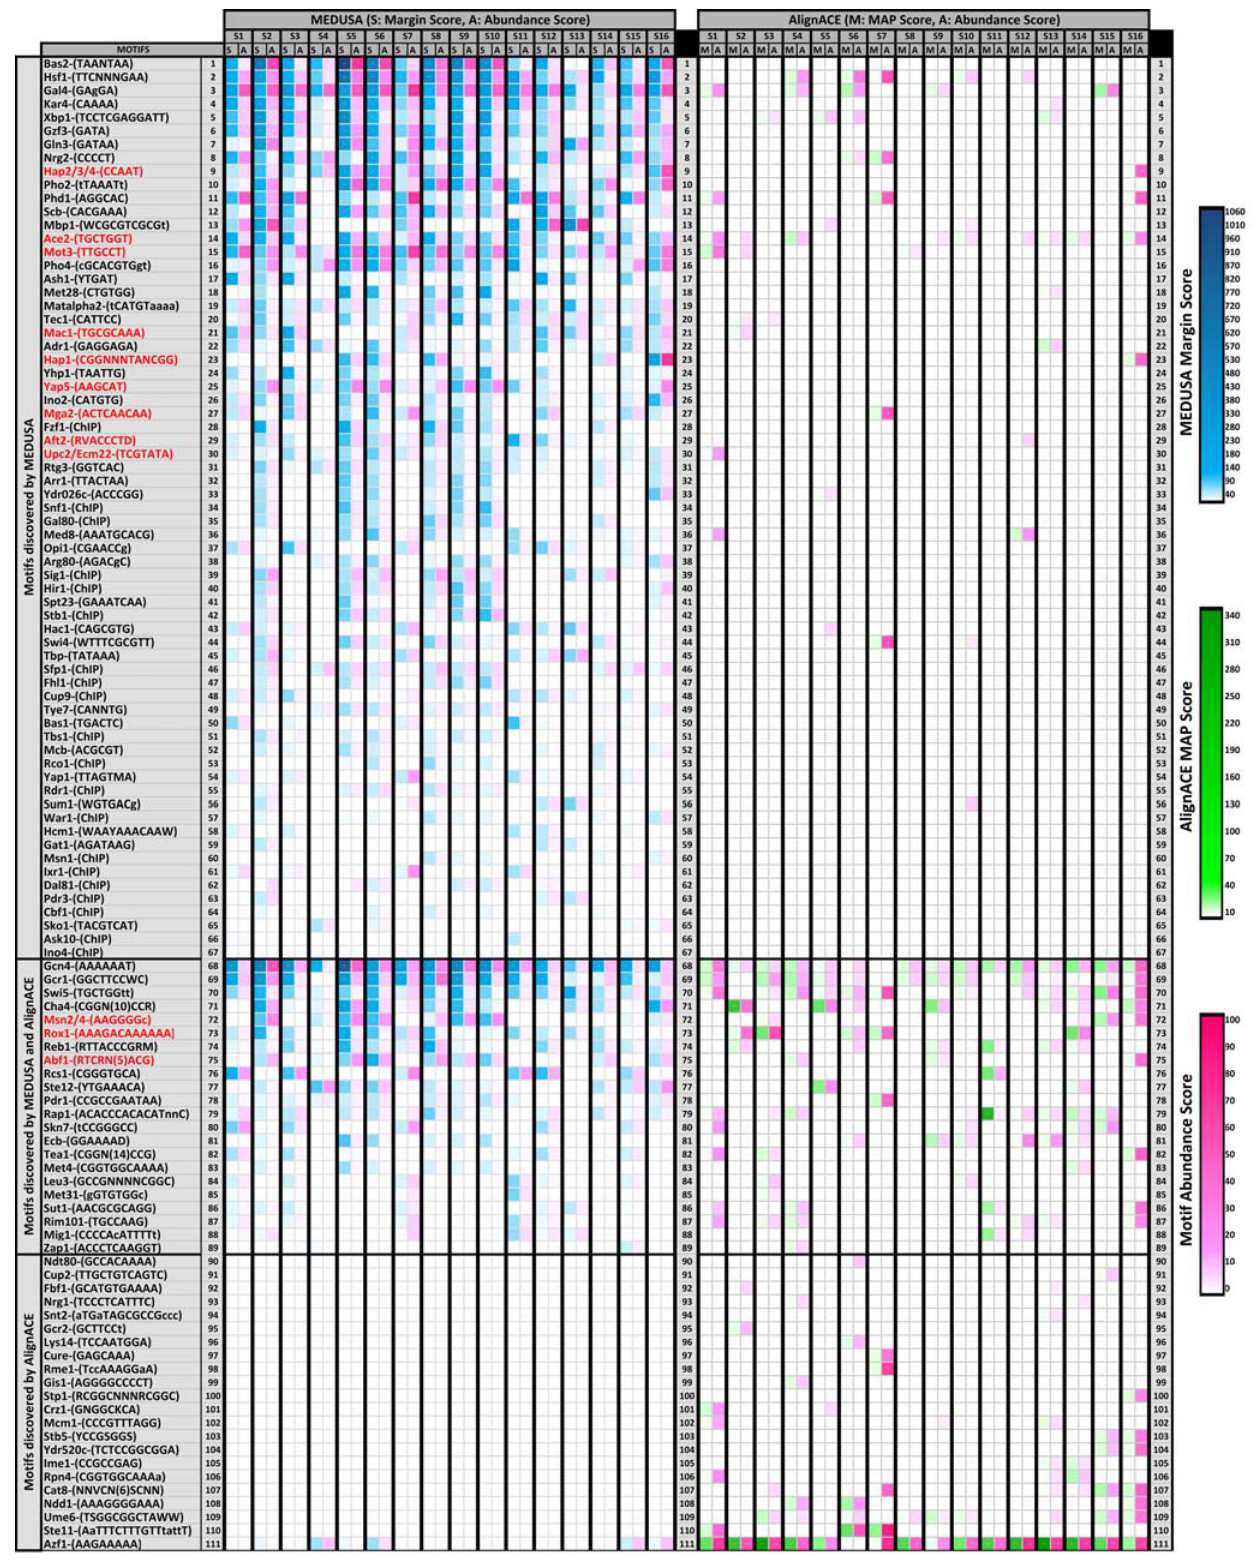
Figure 8. Comparison of significance and abundance of motifs learned by MEDUSA and AlignACE for the 16 expression signatures identified in the dataset. Each row in the table represents a motif found by MEDUSA only (top section), by both MEDUSA and AlignACE (middle section), or by AlignACE only (bottom section). The first column describes the motif by the name of the corresponding transcription factor followed by the consensus motif sequence. Some transcription factor names are followed by ‘ChIP’, indicating that these are significant ChIP-chip occupancy